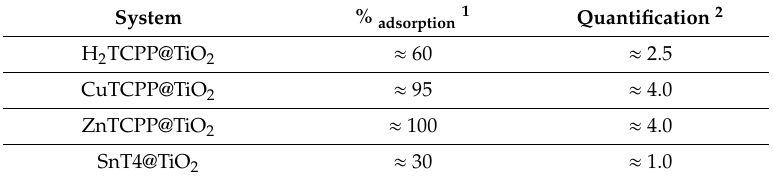
Table 1. Percentage of adsorption and quantification of the investigated